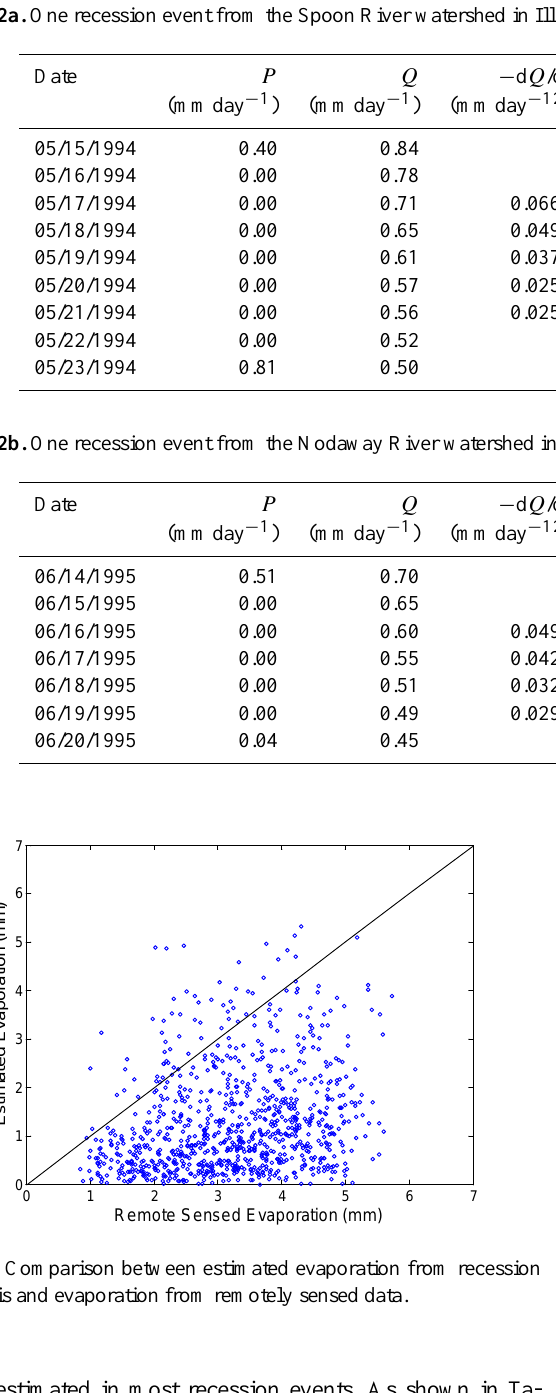
Table 2a. One recession event from the Spoon River watershed in Illinois in May 1994.